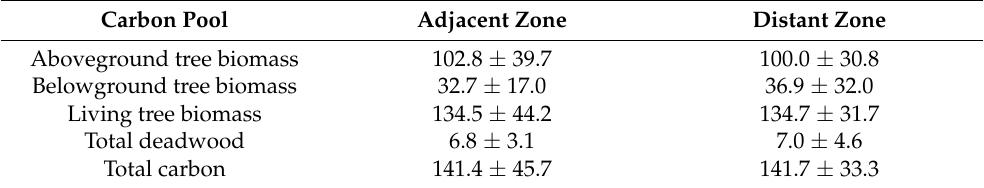
Table 3. The estimated woody carbon pools (mean ± standard deviation, Mg C ha − 1 ) of the studied small and medium river riparian forest stands in Latvia according to distance from the bank of stream. Carbon Pool Adjacent Zone Distant Zone Aboveground tree biomass